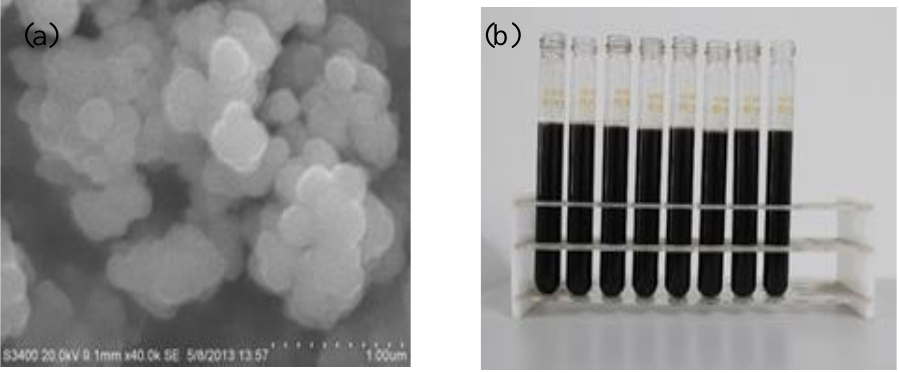
Figure 4. ( a ) Scanning Electron Microscope (SEM) image of CuO nanoparticles; ( b ) Photos prepared CuO/oil nanofluid used in the